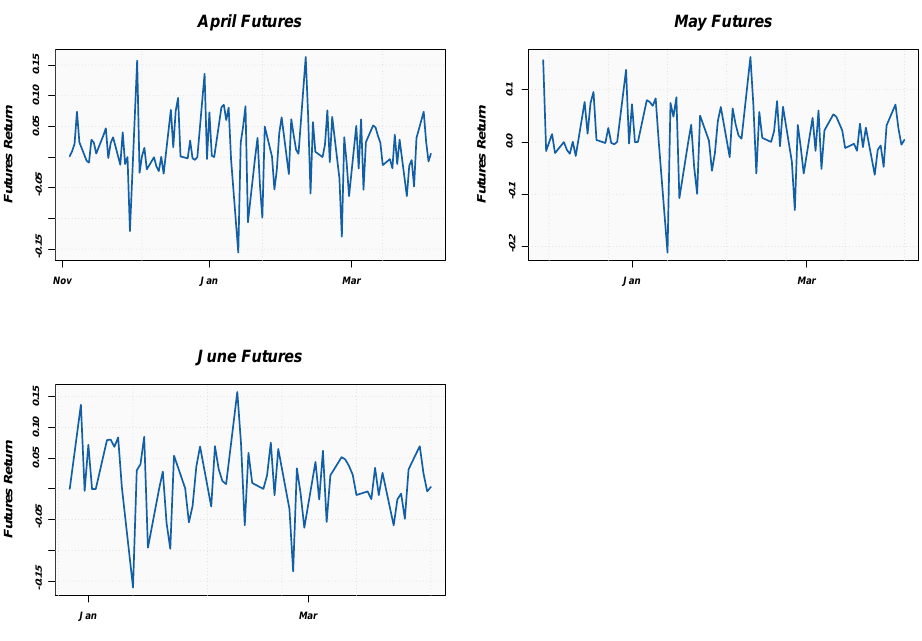
Figure 2. Bitcoin futures